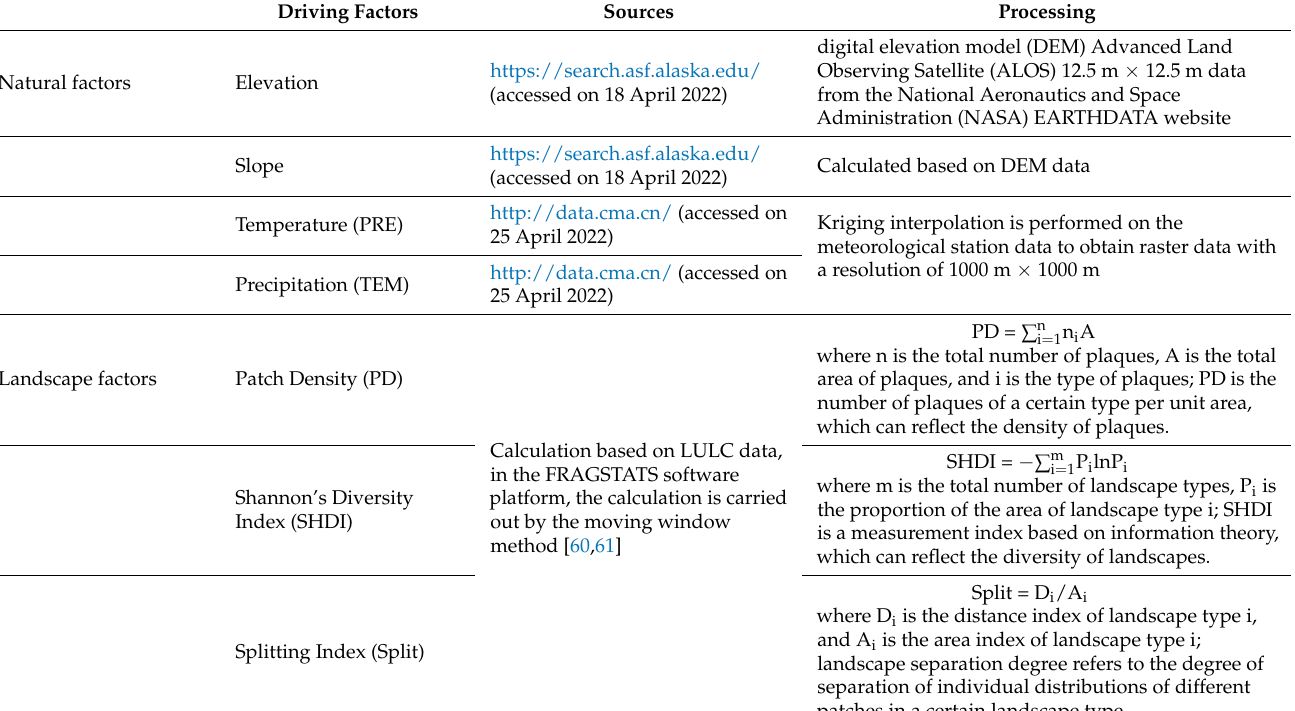
Table 2. Selection of driving factors and data